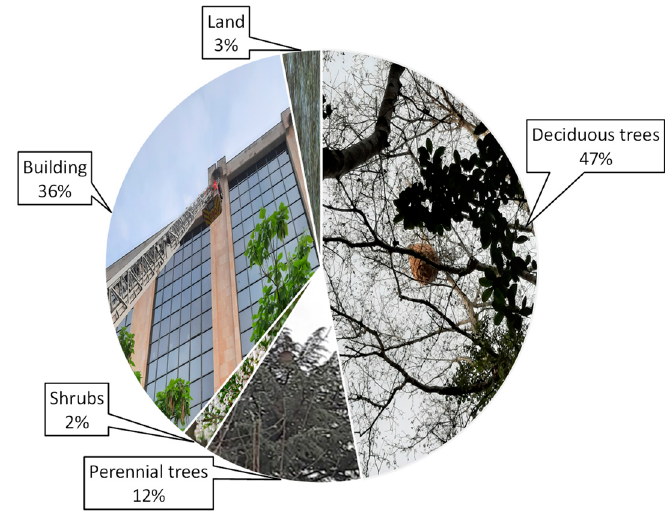
Figure 2. Classification of nests according to their location.